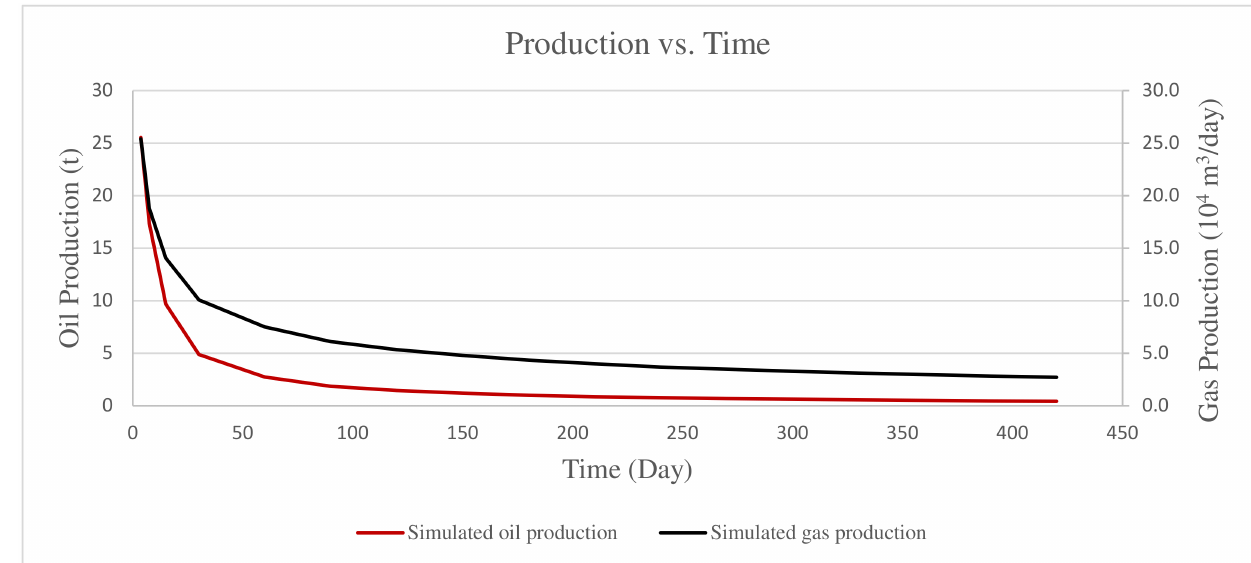
Figure 18. Plot of gas production data with time of the tilt-down well example.